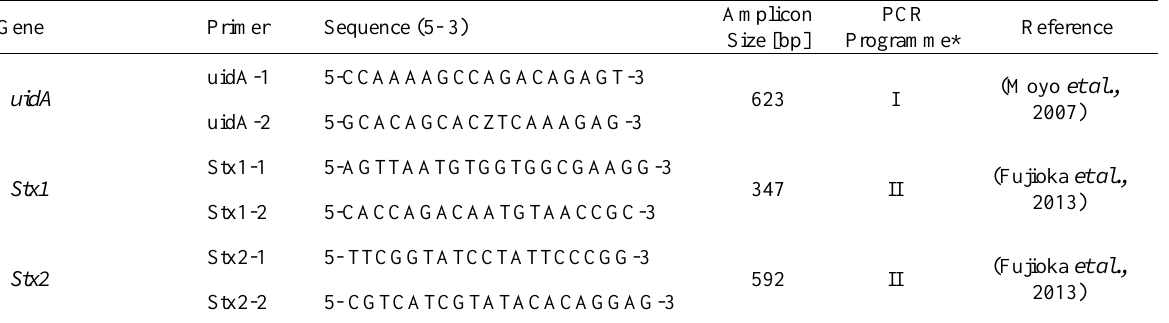
Table 1: PCR programs and primers for detecting E. coli O157:H7 uidA, Stx1, and Stx2 genes Gene Primer Sequence (5-